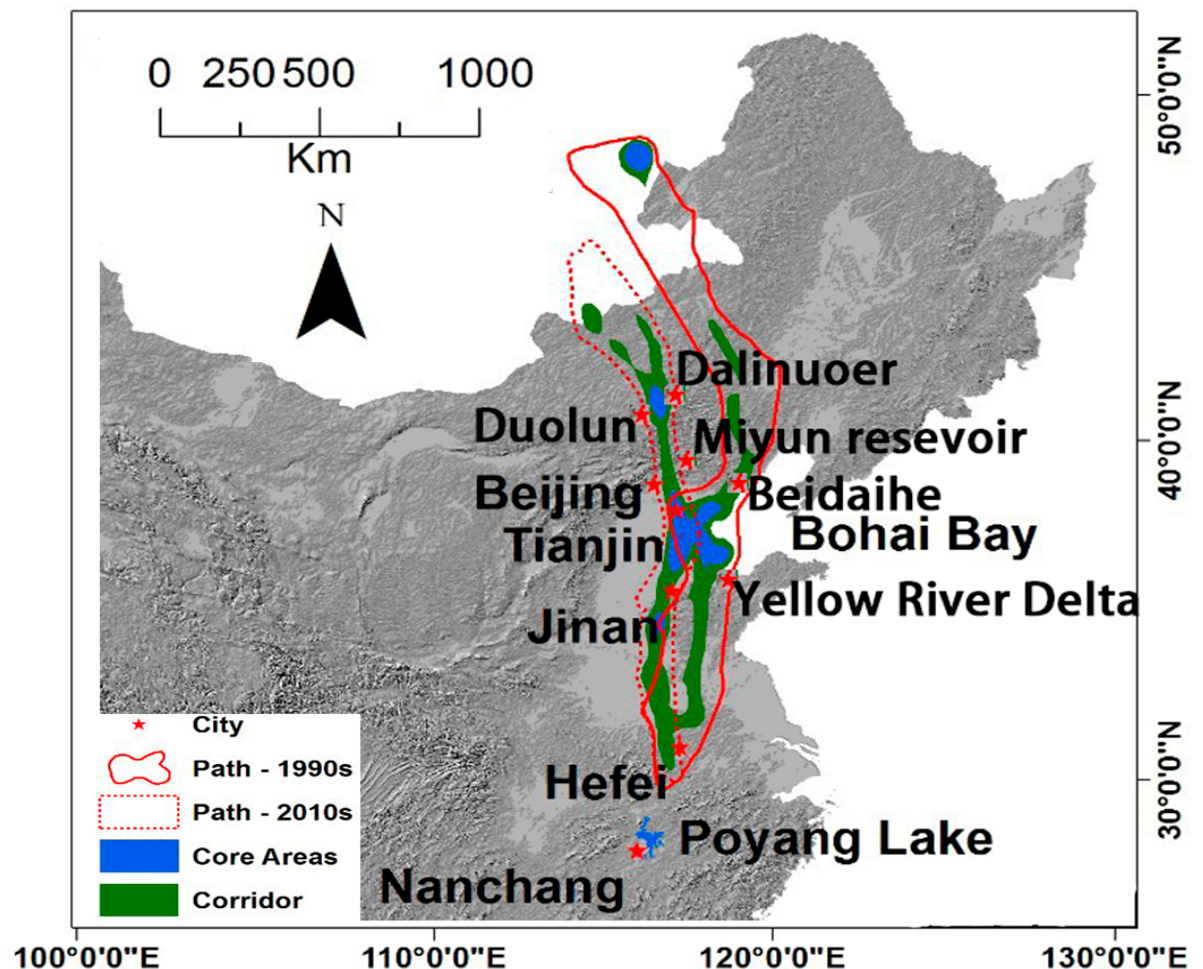
Figure 1. The extended migratory paths of the white-naped crane during the early 1990s (solid red) and early 2010s. The paths and core areas are in green and blue, respectively. The 1 km hill shade shows the boundary of China.